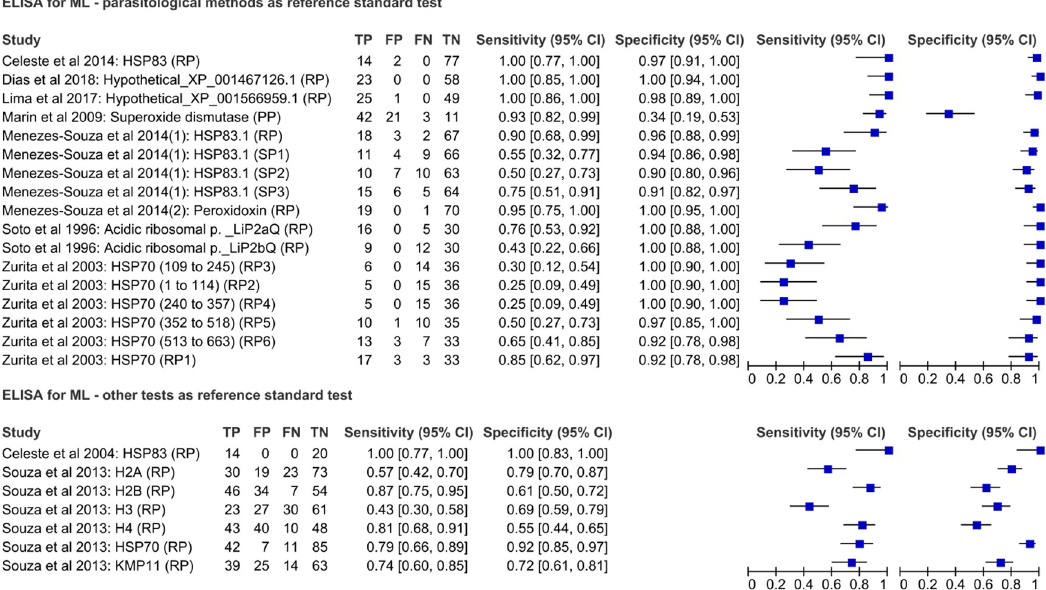
Fig 5. Forest plot representing sensitivity and specificity indexes of other immunological tests using different antigenic targets for ML-diagnosis.